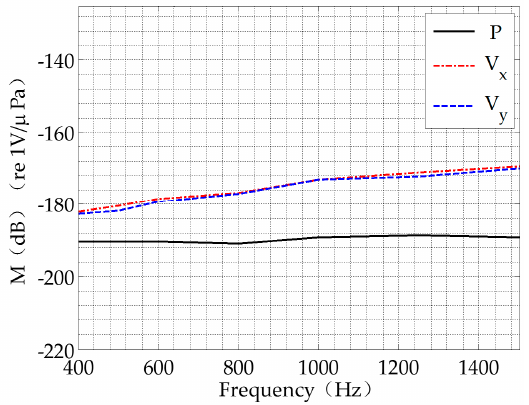
Figure 10. The AVS sensitivity between 400 and 1500 Hz.